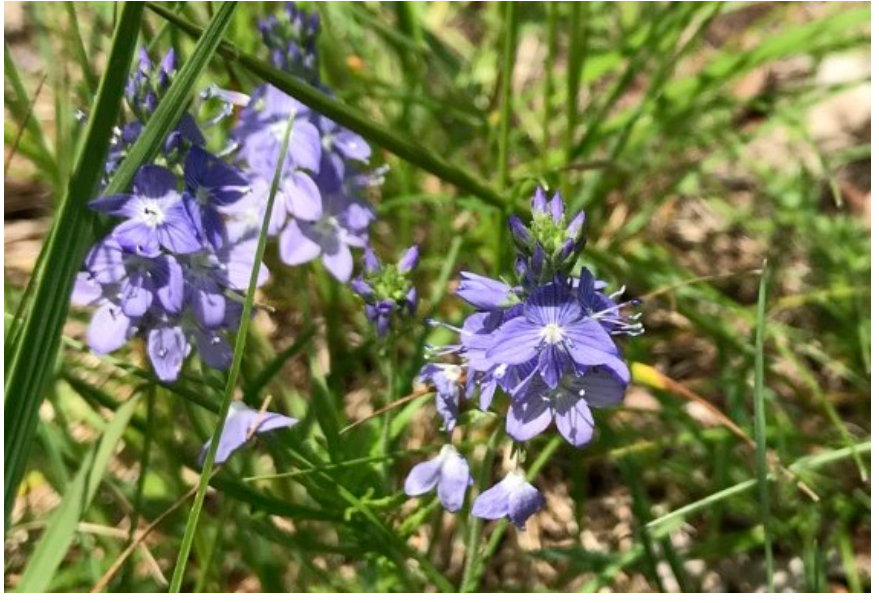
Figure 1. Veronica austriaca ssp. jacquinii in its natural habitat (Lika, Croatia).